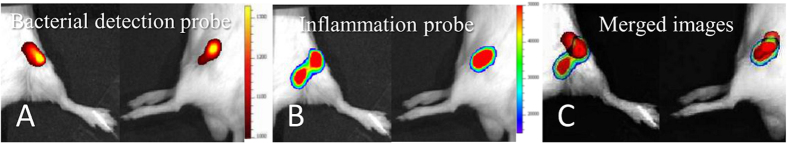
Visualization of the inflammatory area in P. acnes osteomyelitis.A NIR-fluorescent bacterial detection probe and a chemiluminescent inflammation probe were injected into each mouse. The P. acnes growth area (A) and inflammatory area (B) were observed by fluorescence imaging (FRI) and bioluminescence imaging (BLI), respectively, in each mouse. The merged images revealed that the luminescent inflammation area covered most of the bacterial fluorescent signal area (C). The chemiluminescent inflammation probe specifically bound to neutrophils at the inflammation area in the P. acnes osteomyelitis.